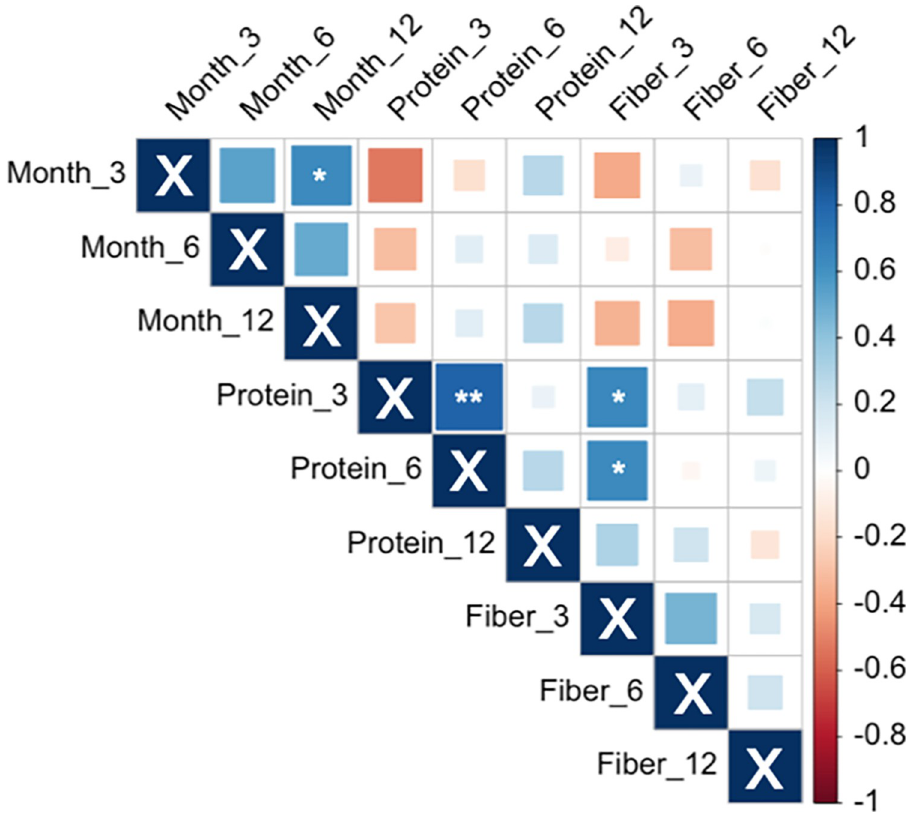
Fig 8. Correlation matrix showing the interrelationship among weight loss and protein and fiber density at three months, six months, and 12 months. Positive correlations are displayed in blue and negative correlations in red. � p < 0.05, �� p <